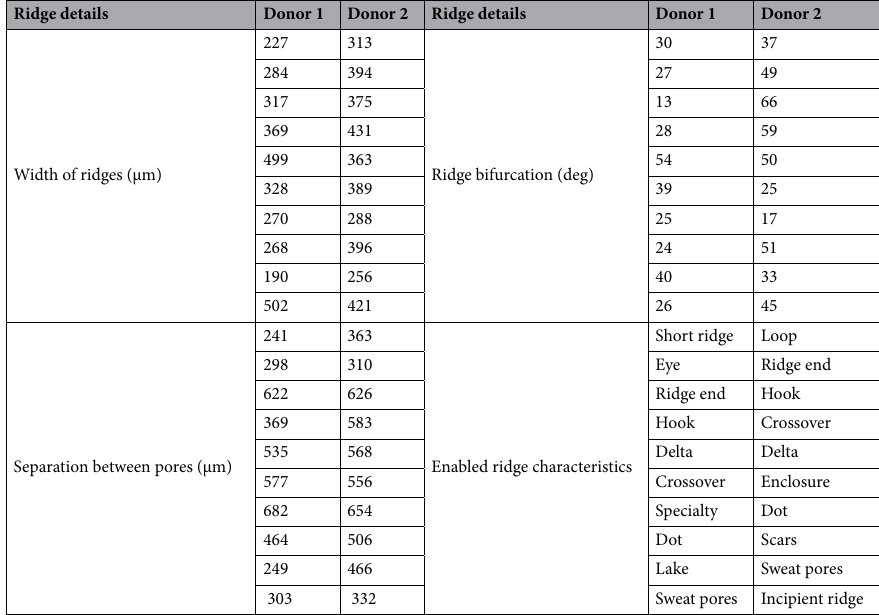
Table 2. List of various minute level-III ridge details of the developed FPs of two different